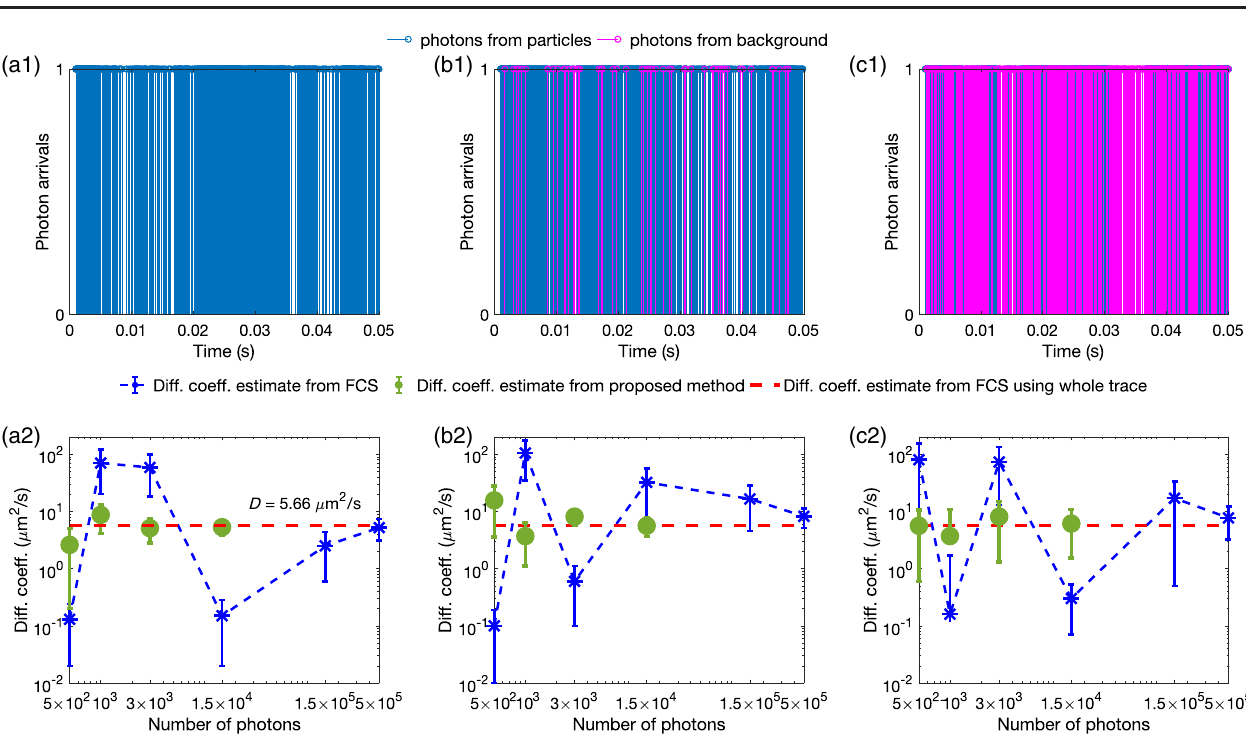
FIG. 11. Background photon emission rates are artificially added to experimental traces yielding challenging imaging conditions and broader diffusion-coefficient estimates. Experimental traces with fixed concentration 1 nM of Cy3 dye molecules and 67% glycerol and fixed laser power 100 μ W. The same total number of photons analyzed under differing (artificially increased) background photon emission rates [0 (a1), 500 (b1), 1000 (c1) photons/s] (a2),(b2),(c2) Similarly to Fig. 1, we compare our method ’ s diffusion-coefficient estimate (green dots) to FCS (blue asterisk) as a function of the number of photons used in the analysis. Since by 1 . 5 × 10 4 photon arrivals our method has converged, we avoid analyzing larger traces. The red dashed line is the FCS estimate obtained from the entire 5-min trace containing ≈ 3 × 10 6 photon